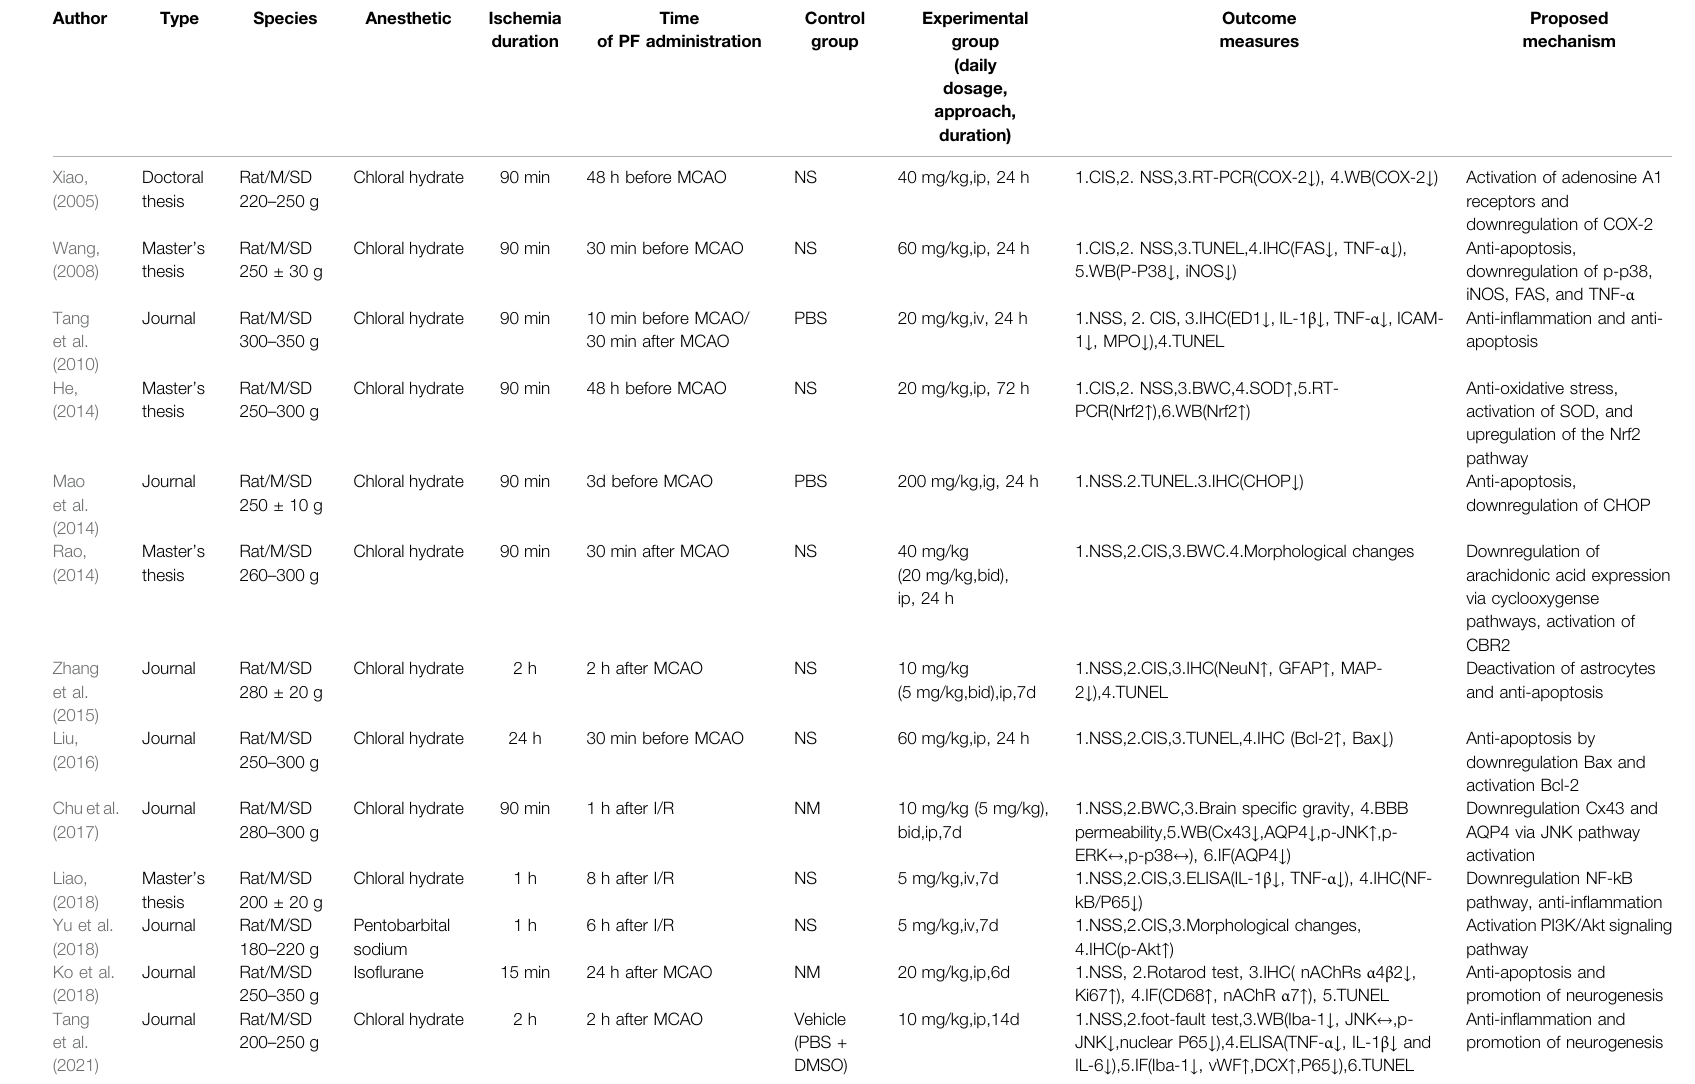
TABLE 1 | Basic characteristics of the included